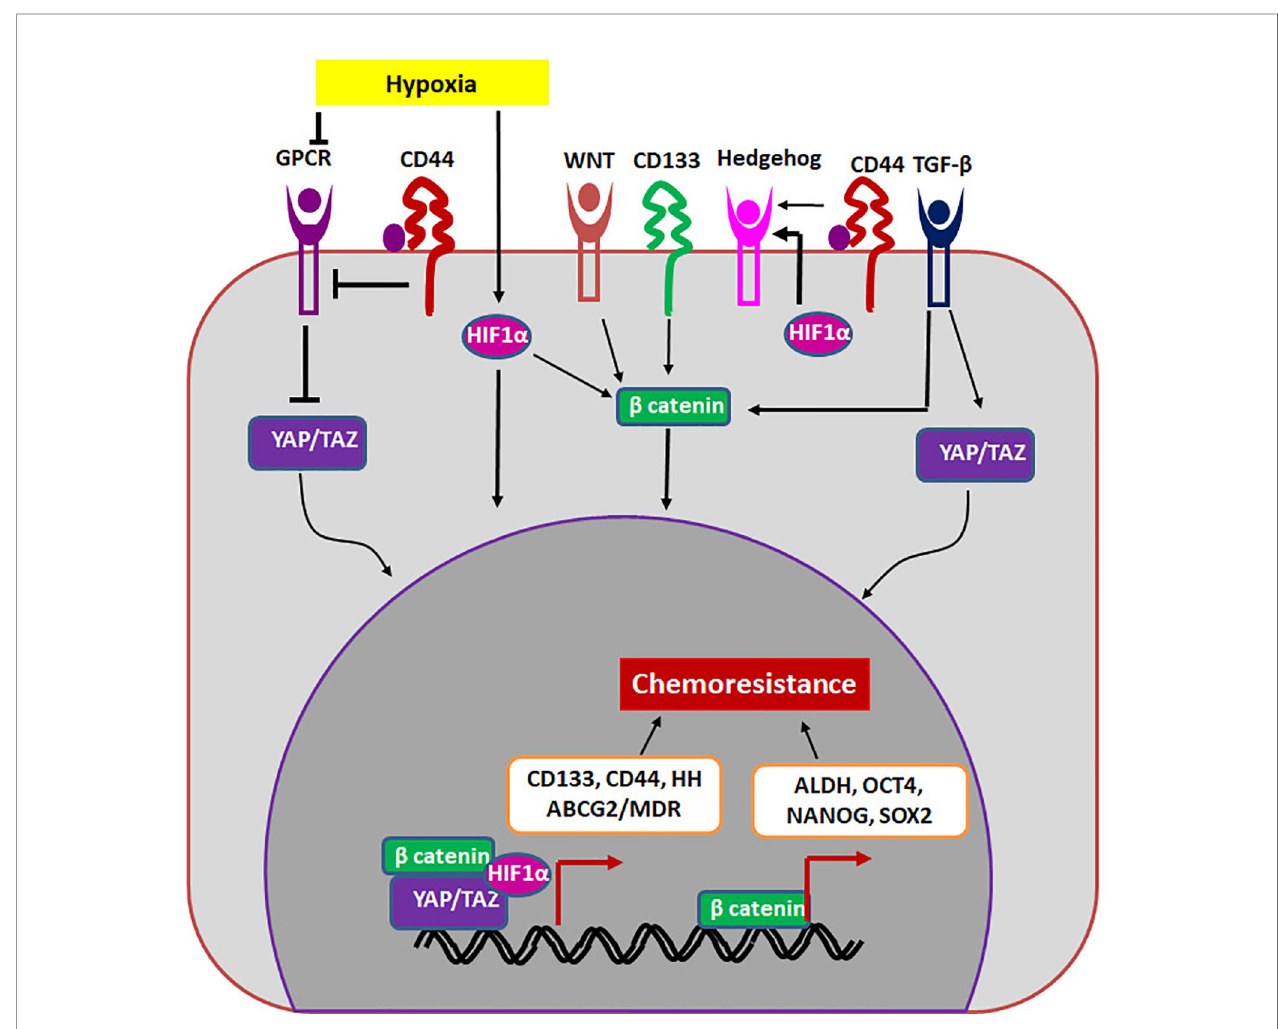
FIGURE 2 | The regulation of drug resistant CSCs. The niche factors activates several self-renewal pathways like HIF1 a , WNT, Hedgehog or TGF- b that regulate chemoresistance in a b -catenin dependent way. Other self-renewal markers like CD44 and CD133 can also regulate chemoresistance. CD133 regulates b -catenin, while CD44 regulates Hippo signaling (YAP/TAZ) to induce chemoresistance. The transcription complexes indicated in the fi gure results in the up-regulation of molecules like ALDH and MDR proteins including